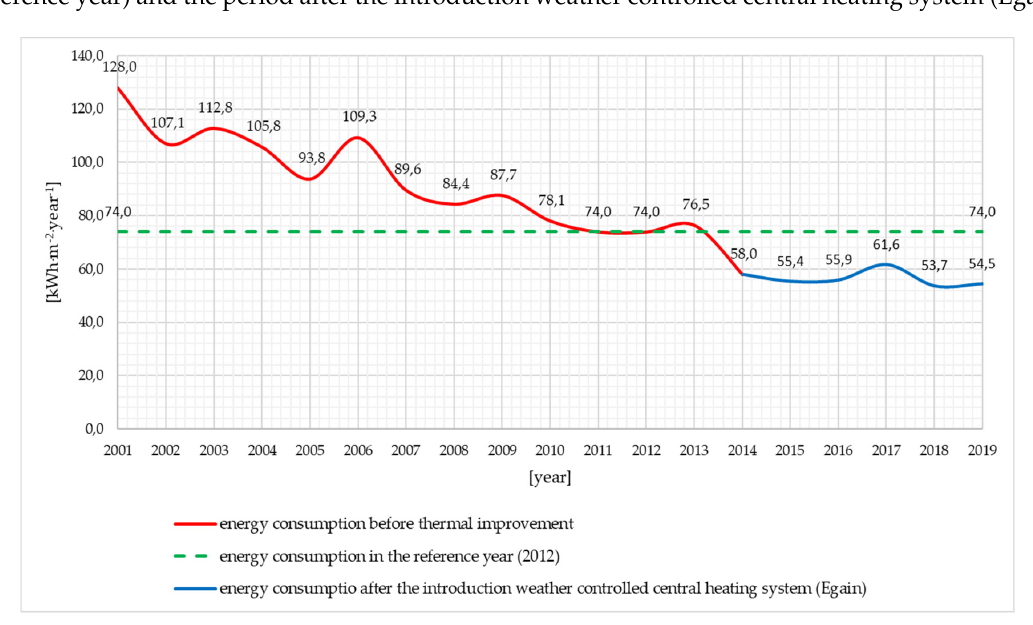
Figure 2. Thermal energy consumption for central heating in the years 2001–2019 in building A.